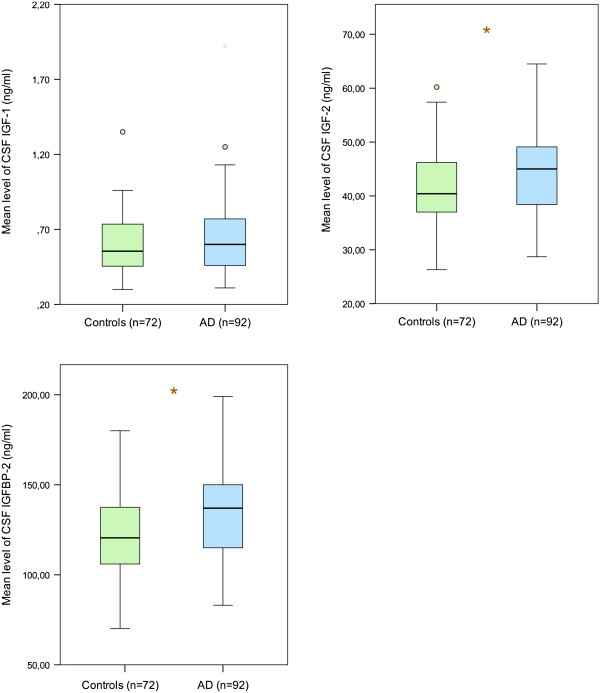
Concentrations of IGF-I, IGF-II and IGFBP-2 (the most abundant carrier in the intrathecal space) in CSF. The lower, upper and middle lines correspond to the 25th percentile, 75th percentile and median, respectively. The whiskers at the top and bottom extend between the 95th and the 5th percentiles. The circles represent outliers. *p < 0.05.